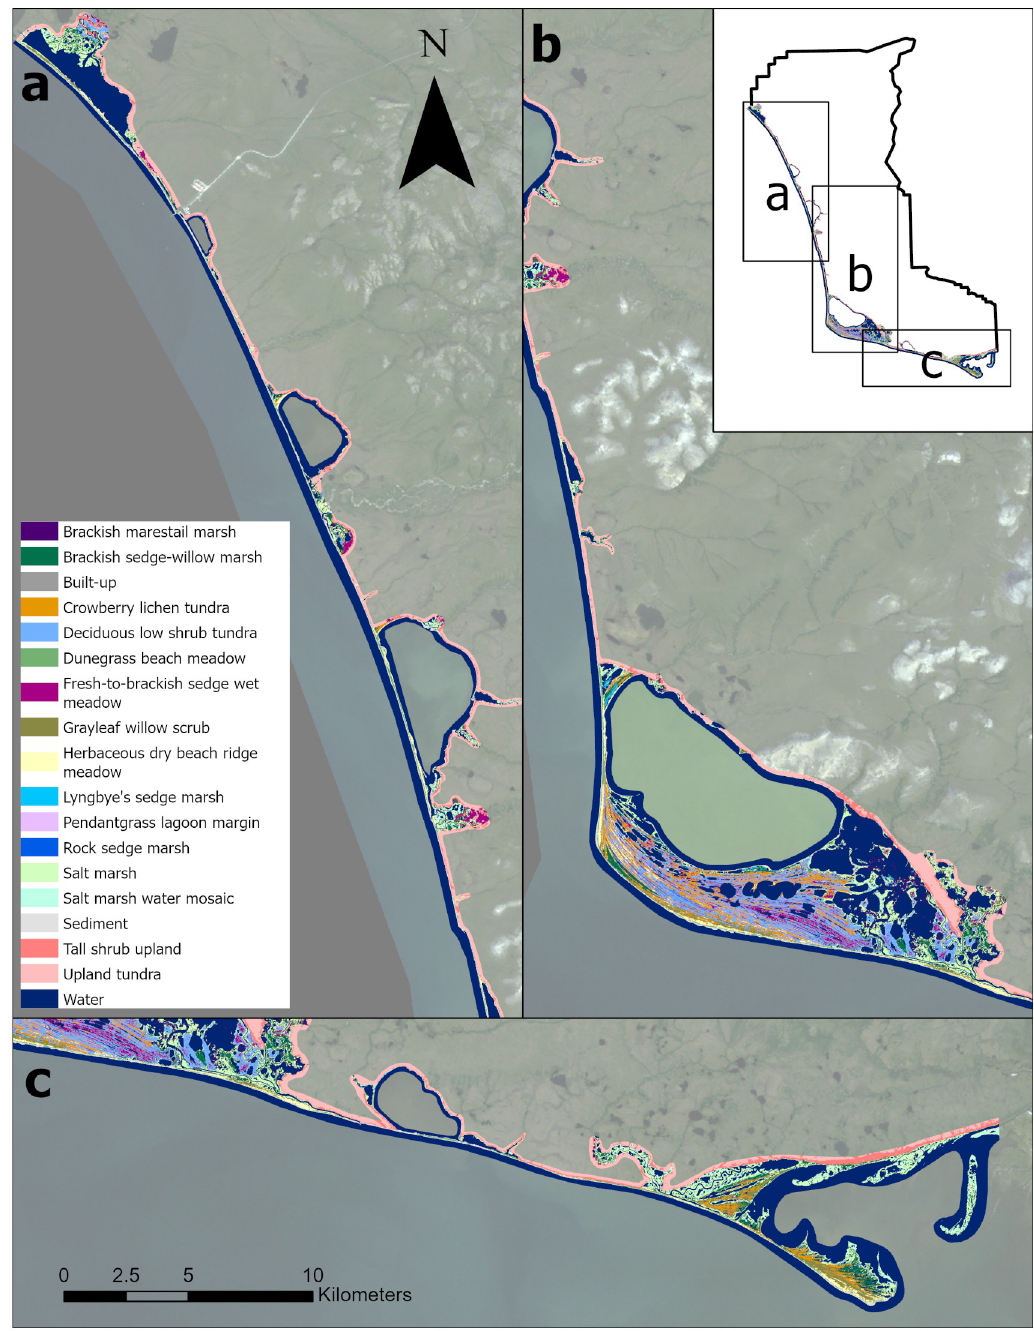
Fig 9. Map of the coastal vegetation of Cape Krusenstern National Monument. Background imagery Landsat mosaic produced for the Arctic Network. https://irma.nps.gov/DataStore/Reference/Profile/2171608 Public